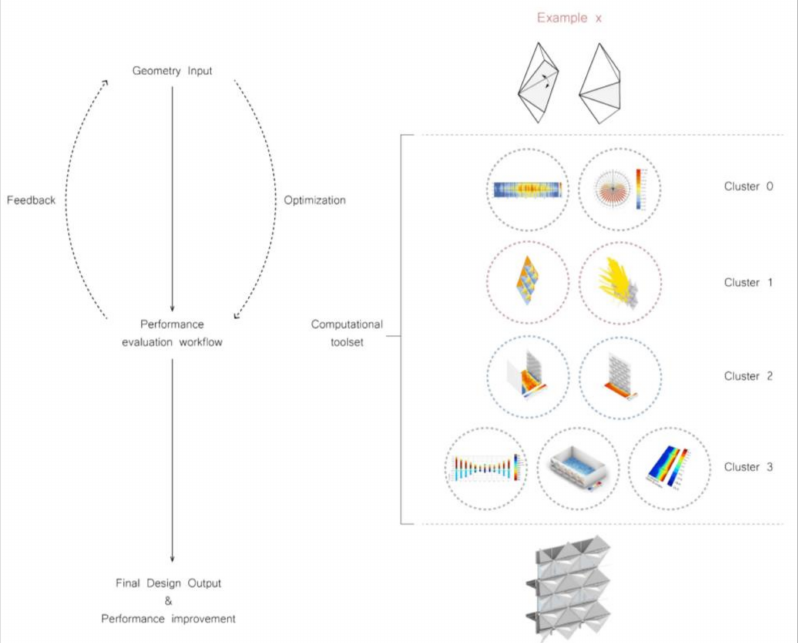
Figure 31. The feedback-optimization logic of the performance evaluation as part of the computa- tional tool workflow and the current design as an example of its application in